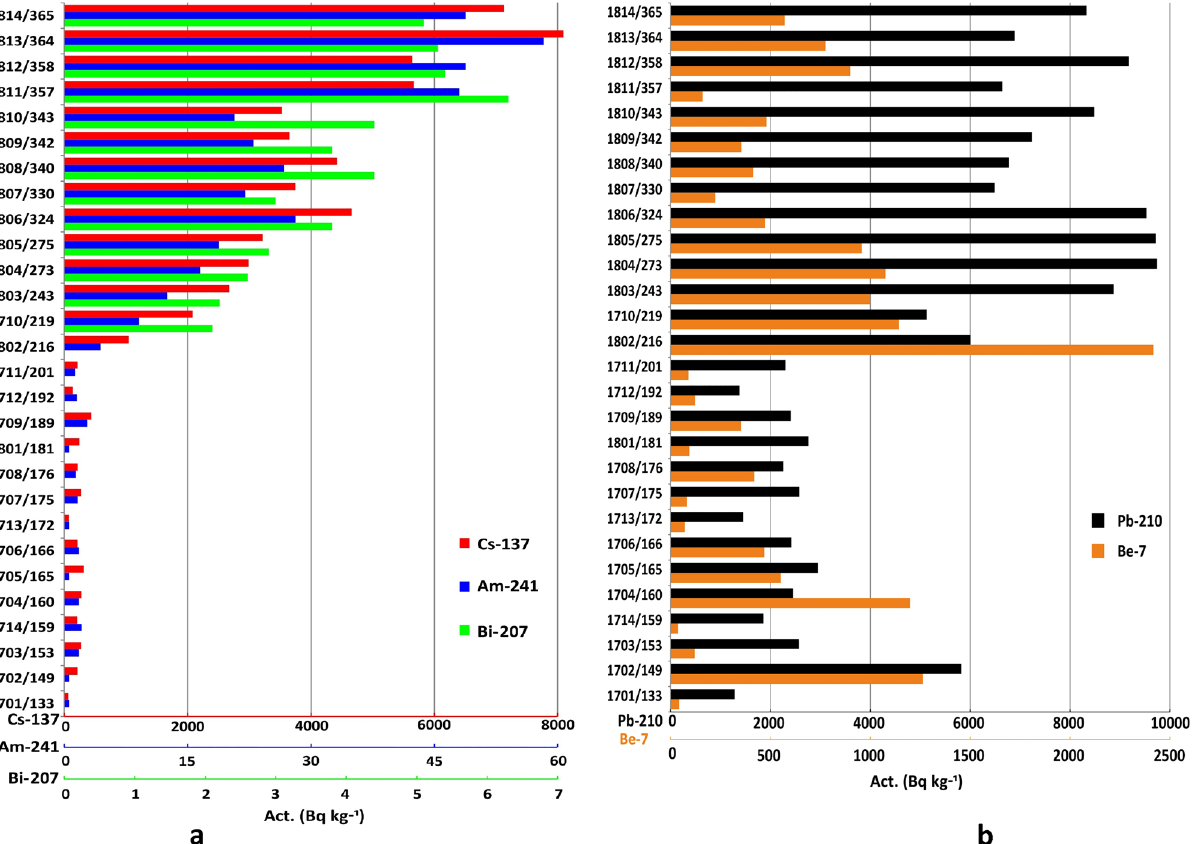
Figure 3. Activity of anthropogenic ( 137 Cs: red, 241 Am: blue, and 207 Bi: green) ( a ) and natural ( 210 Pb: black and 7 Be: orange) ( b ) radionuclides in cryoconite samples. Horizontal axis—activity of radionuclides (Bq kg −1 ); vertical axis—sample/altitude (m